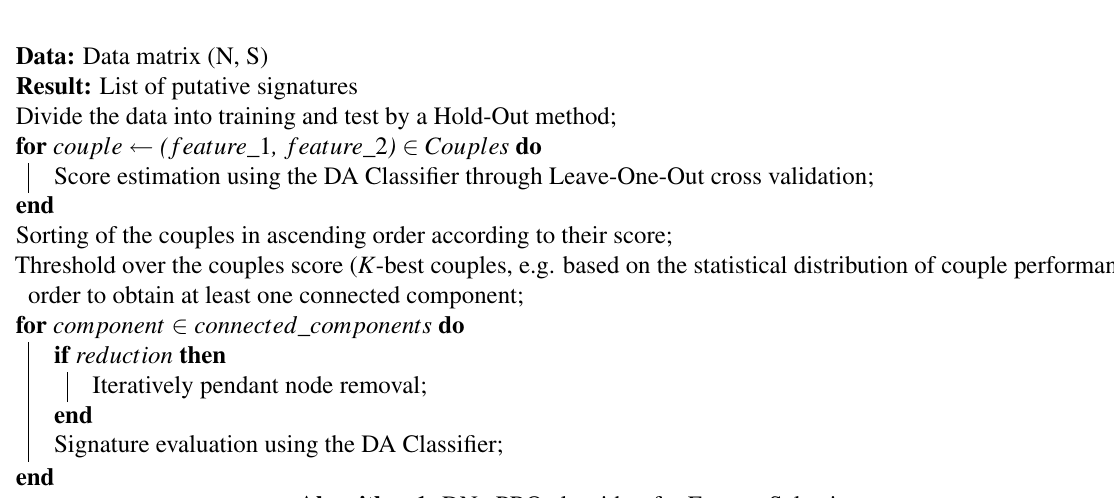
Algorithm 1: DNetPRO algorithm for Feature